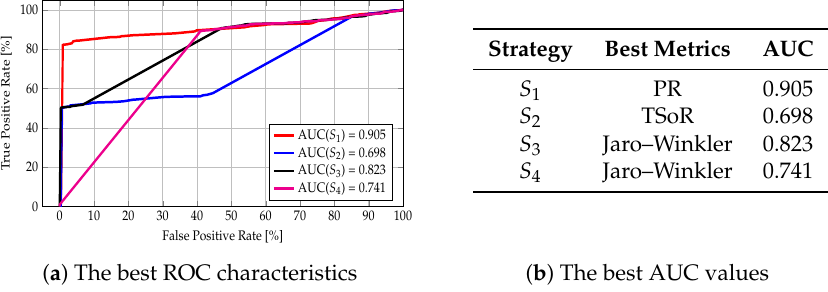
Figure 14. The best AUC values ( b ) and best ROC curves characteristics ( a ) for attribute Phone Number .